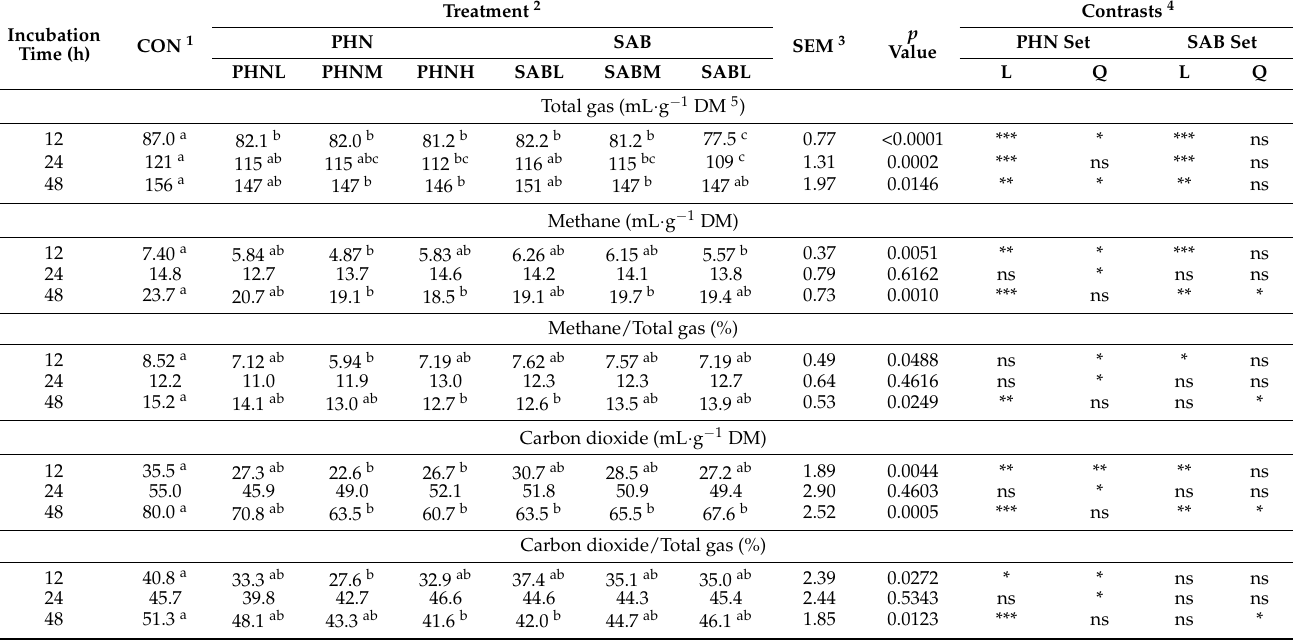
Table 5. Effects of bamboo leaves on gas profiles in in vitro